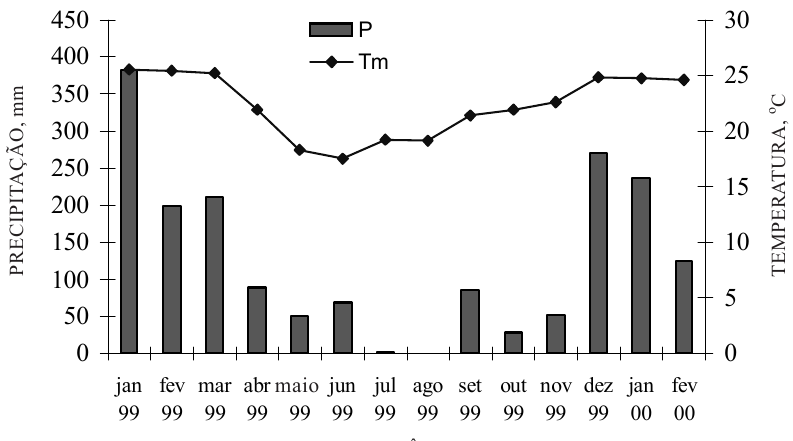
Figura 1. Valores mensais da precipitação pluvial acumulada (P) e da temperatura média (Tm) durante o período experimental de janeiro de 1999 (jan. 99) a fevereiro de 2000 (fev.